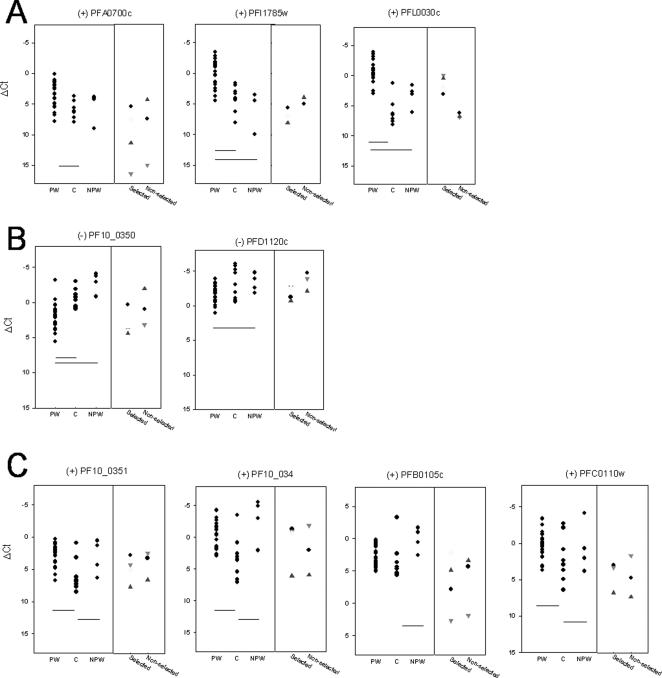
Transcription levels measured by real-time qPCR in parasites from different clinical malaria status.Blocks A to C, left panels correspond to higher transcription levels in: (A) placental parasites from pregnant women at delivery (PW); (B) non placental parasites from children (C) and non placental parasites from non pregnant symptomatic women (NPW); (C) parasites from women (PW or NPW). Shown are transcription levels for 22 parasites isolated from the placenta of women (PW), 9 parasites from asymptomatic children (C) (mean age 10 years) and 4 parasites from symptomatic non-pregnant women (NPW) living in the same area, as well as by (in the right side of each panel) the in vitro cultured P. falciparum strains 3D7 (black dots), FCR3 (red dots), and NF54 (blue dots). Each of these 3 strains were used either non-selected or after selection for CSA binding using panning on soluble CSA (3D7), Bewo cells (FCR3), or VAR2CSA IgGs (NF54). Hb3 (yellow dots) was also studied after selection on Bewo cells. These parasite lines were highly synchronized and aged 24 hours post invasion Missing points correspond to lack of detection of the corresponding gene (in particular for PFI1785w in FCR3). Horizontal bars indicate statistically significant differences between groups. On top, (+) indicates over-expressed in PAM parasites according to array data; (−) indicates under-expressed in PAM parasites according to array data.